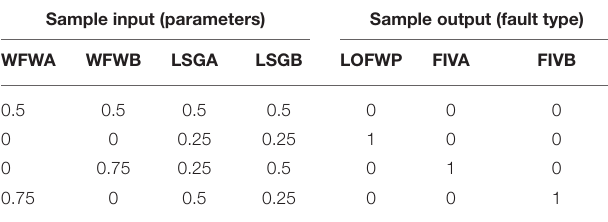
TABLE 1 | Parameter thresholds combined with trends for sample construction.